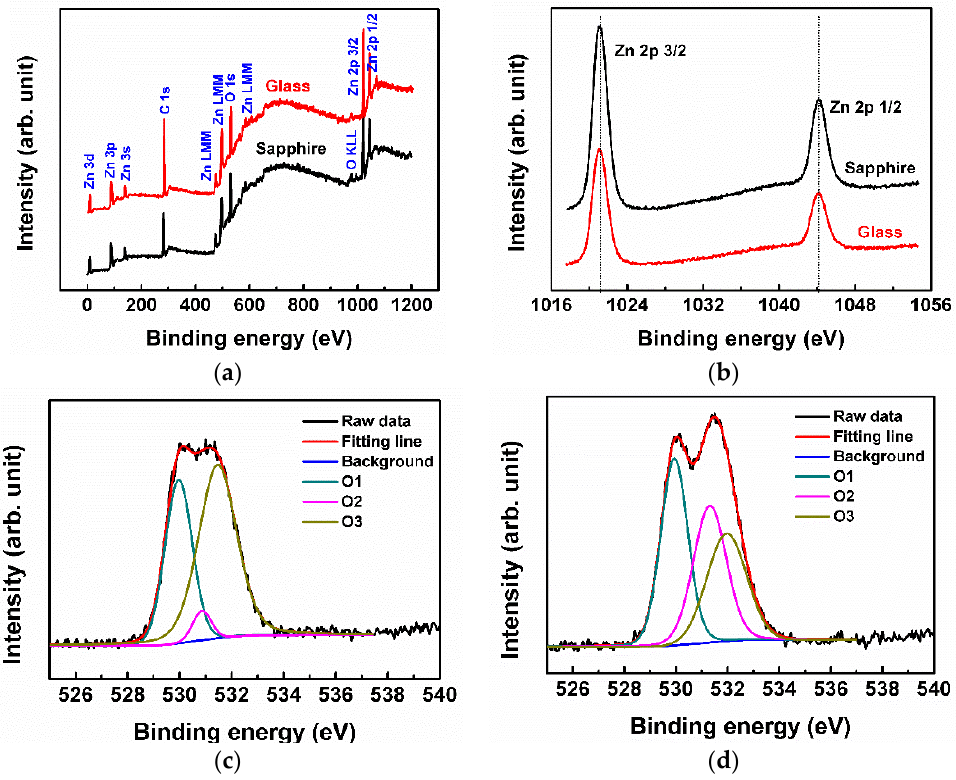
Figure 3. ( a ) X-ray photoelectron spectroscopy (XPS) analysis spectra and ( b ) high-resolution spectra of Zn 2 p region for the as-achieved ZnO thin films grown on quartz glass and sapphire (001) substrates annealed at 600 °C for 1 h, respectively. ( c ) and ( d ) are XPS O 1 s core-level spectra of the as-achieved ZnO thin films grown on quartz glass and sapphire (001) substrates annealed at 600 °C for 1 h, respectively. Table 2. Oxygen-related XPS characteristic parameters for the as-grown ZnO thin films on quartz glass and sapphire (001) substrates annealed at 600 °C for 1 h.